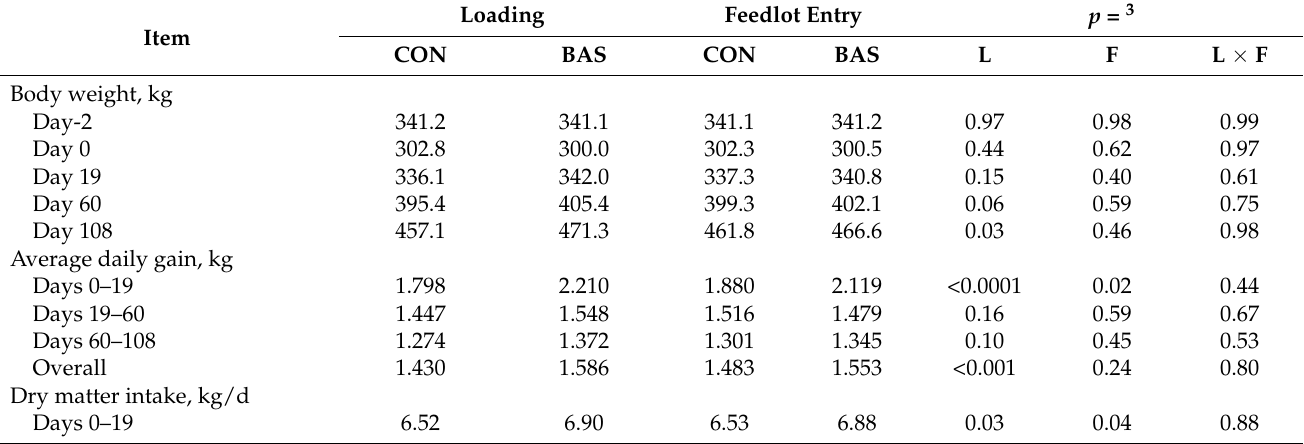
Table 4. Effects of administering (BAS) or not (CON) bovine appeasing substance to beef bulls at loading and/or at feedlot entry 1,2